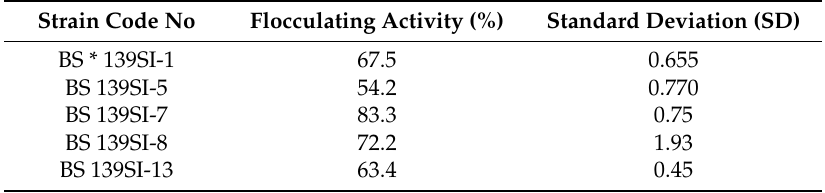
Table 1. Flocculating activity values for the selected strains.